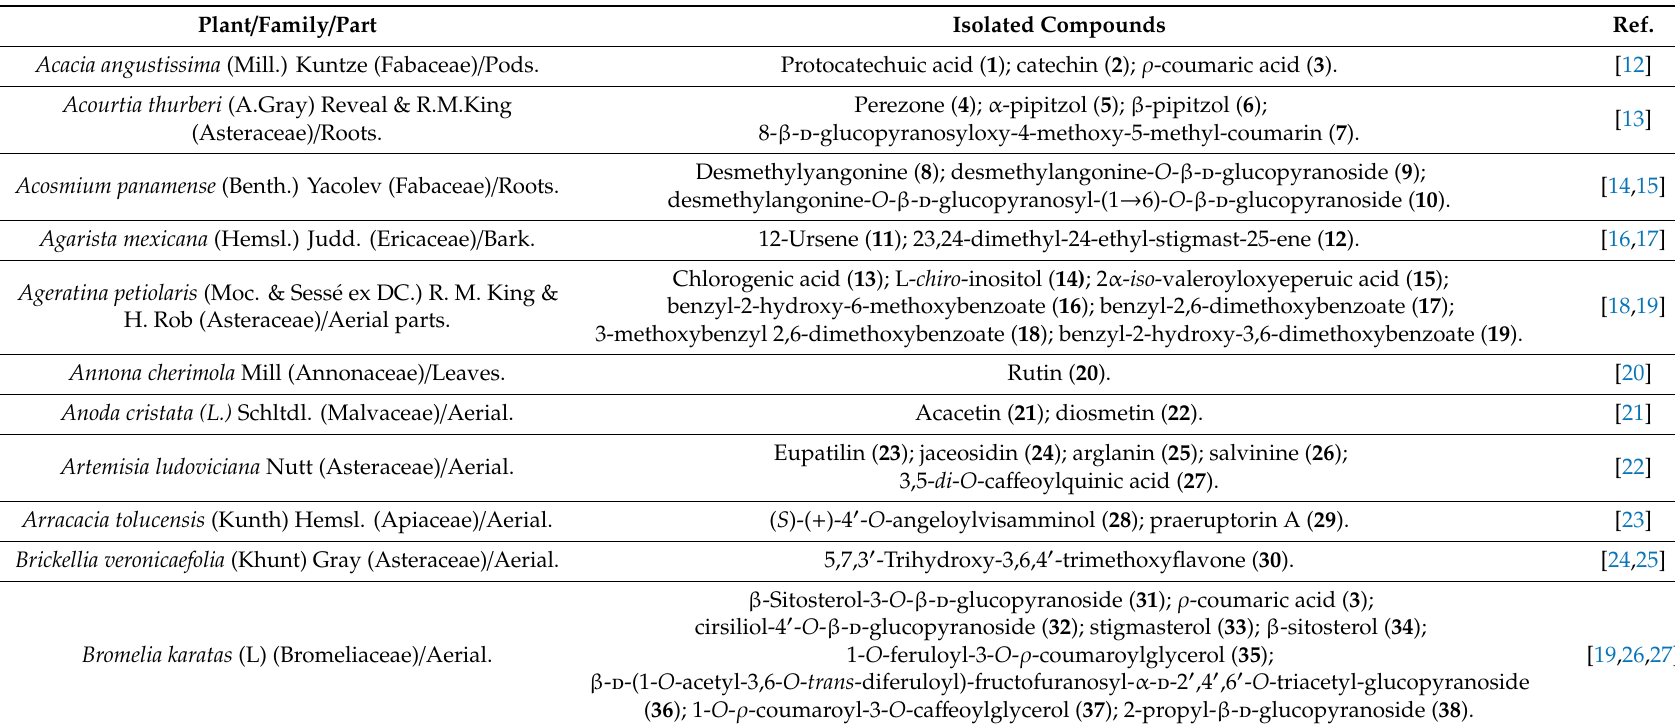
Table 1. Isolated Compounds from Hypoglycemic Mexican plants. Plant / Family /